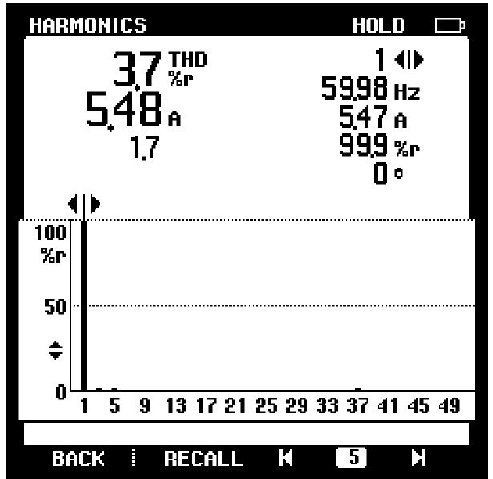
Figure 13. THD of the input current of the CC.